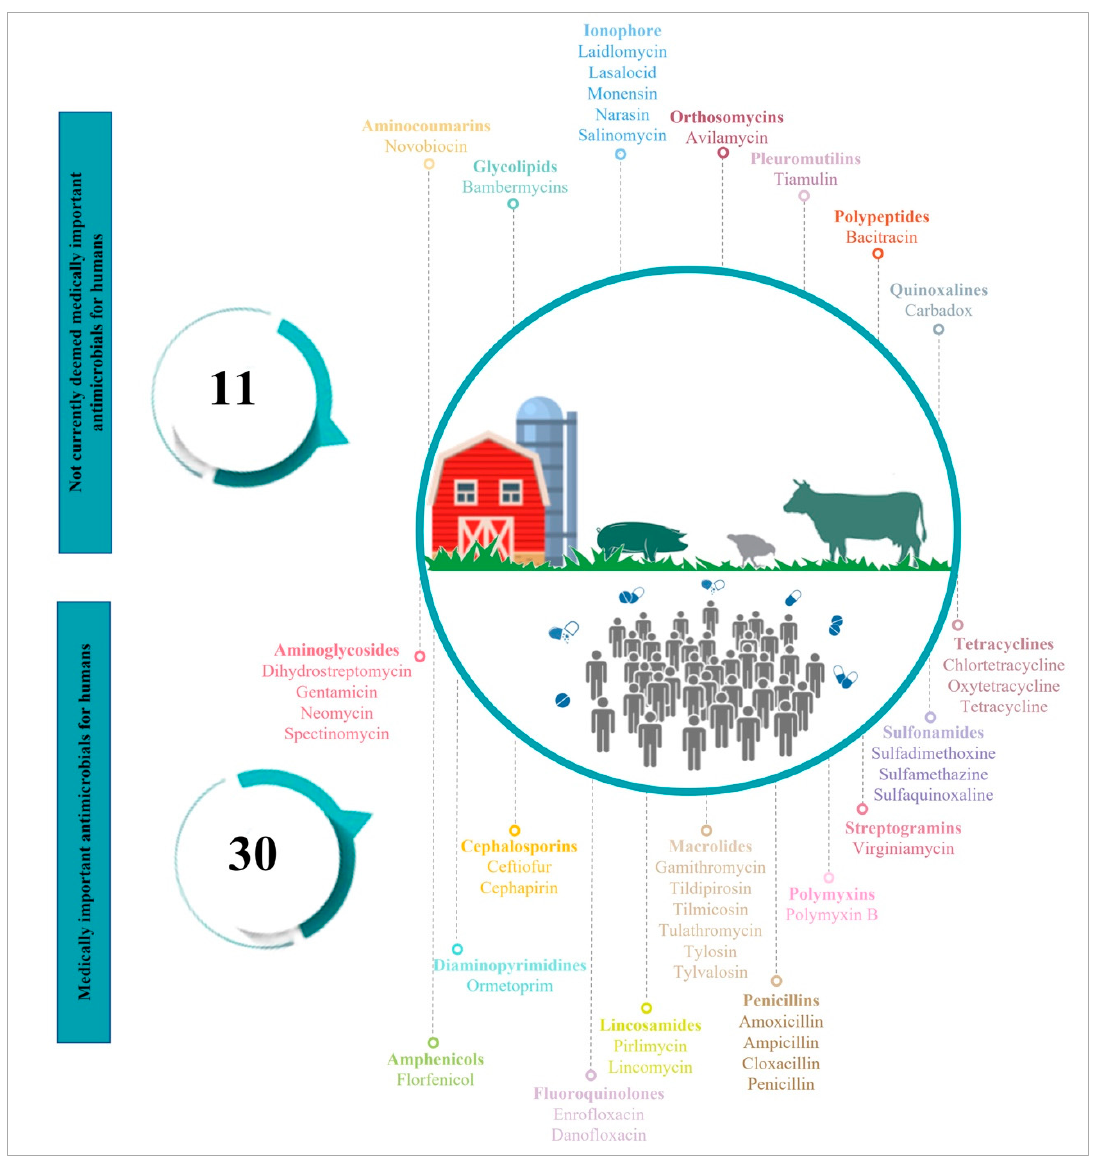
Figure 2. Classification of antimicrobials used in food-producing animals according to their im- portance for humans (Food and Drug Administration (FDA). According to the FDA, among the 41 antimicrobials (including ionophores) that are approved for use in farm animals in 2020, 30 are cat- egorized as being medically important for humans [32]).